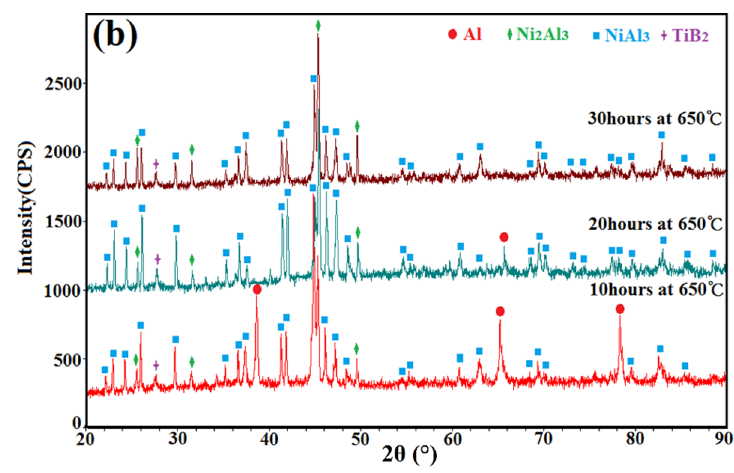
Figure 9. XRD patterns of the annealed Ni/Al-TiB 2 coating at different annealing time: ( a ) Ni/Al-TiB 2 coating as-sprayed at 250 °C and ( b ) Ni/Al-TiB 2 coating as-sprayed at 450 °C.